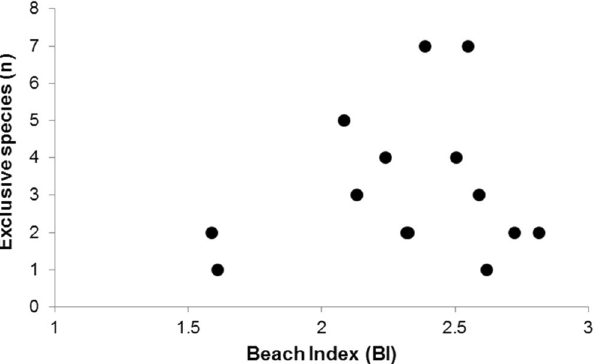
Figure 2. Number of exclusive species found at each beach, classified based on the beach index (BI). No statistical trend is observed in this